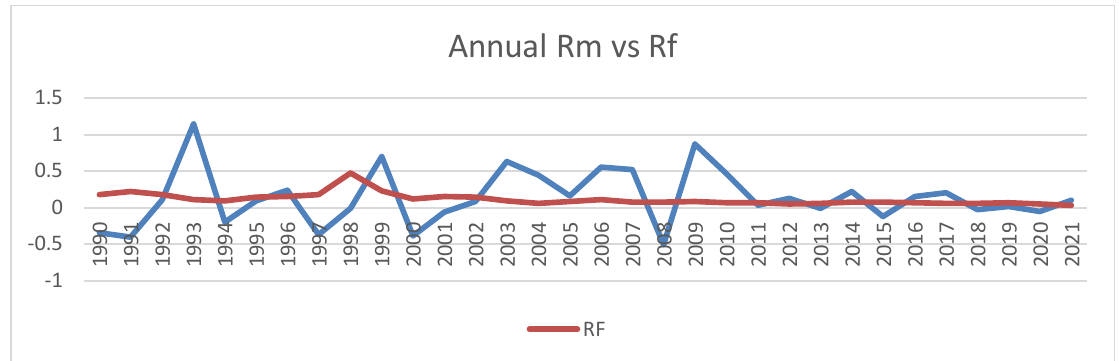
Figure 2: Comparison of Annual Stock Market Return (Rm) and Risk-Free Investment